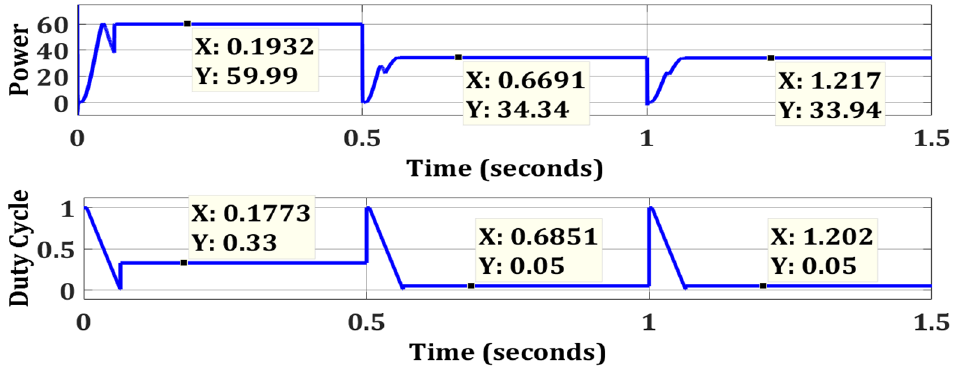
Figure 35. Changing weather conditions for 2S PV system .